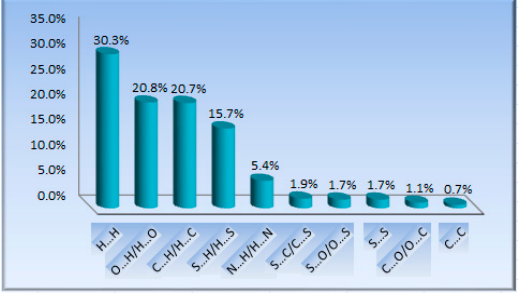
Figure 4. The percentage contributions of each interaction to the Hirshfield surface for matc.